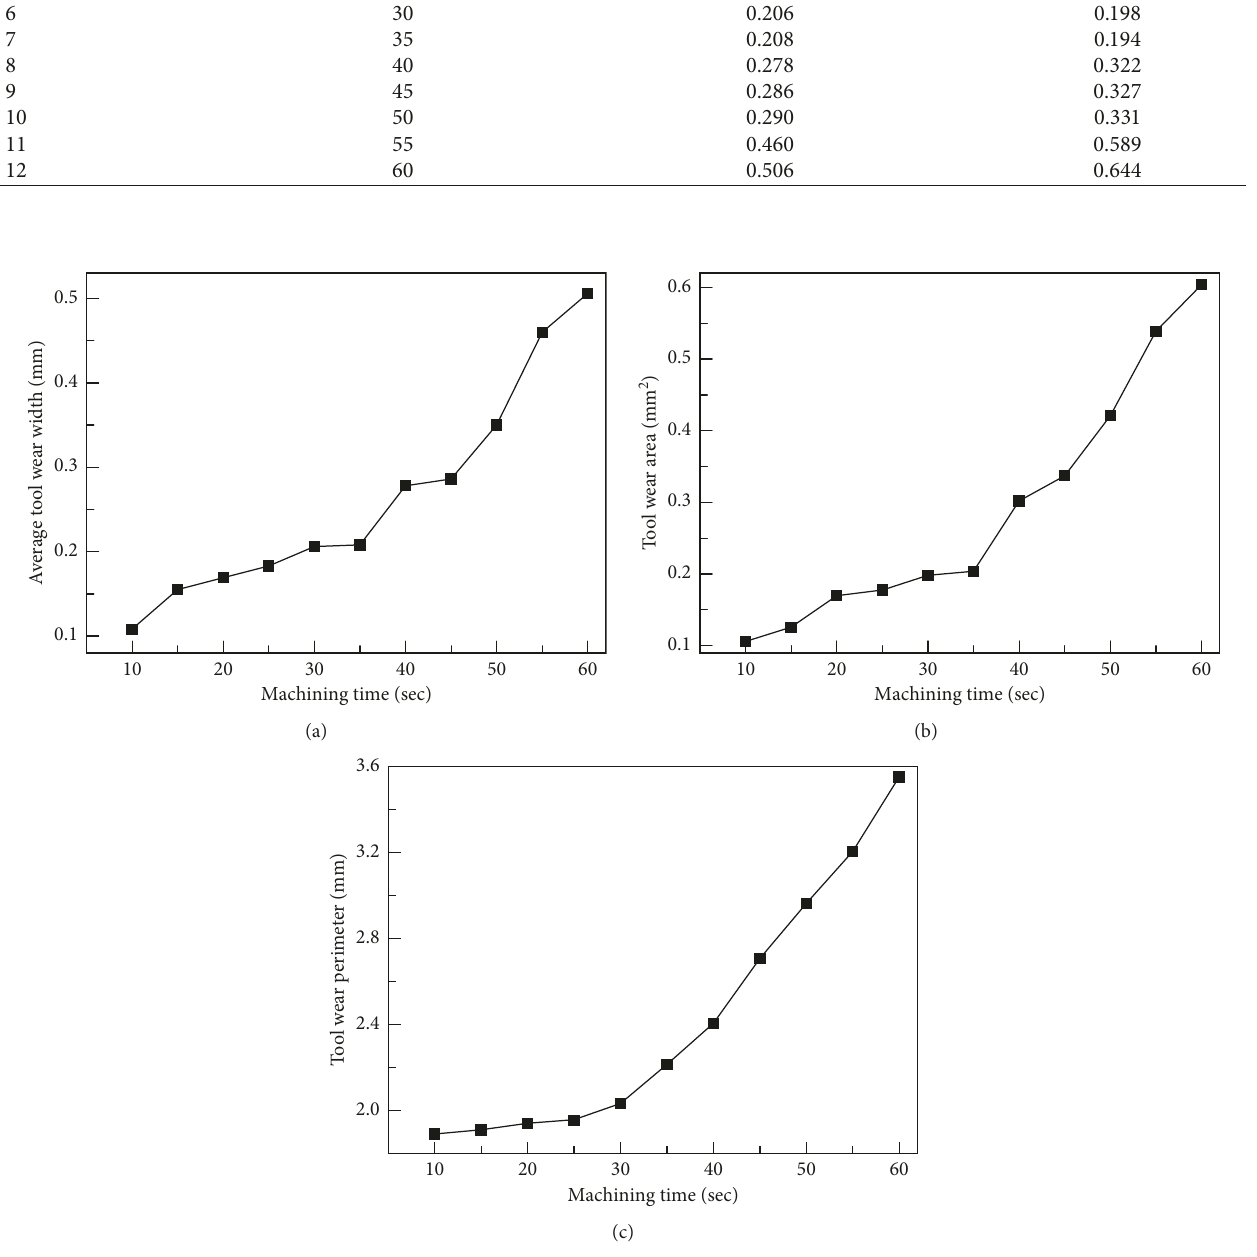
Figure 8: Variation of (a) average wear width; (b) wear area; (c) wear perimeter of the carbide insert with the machining time.